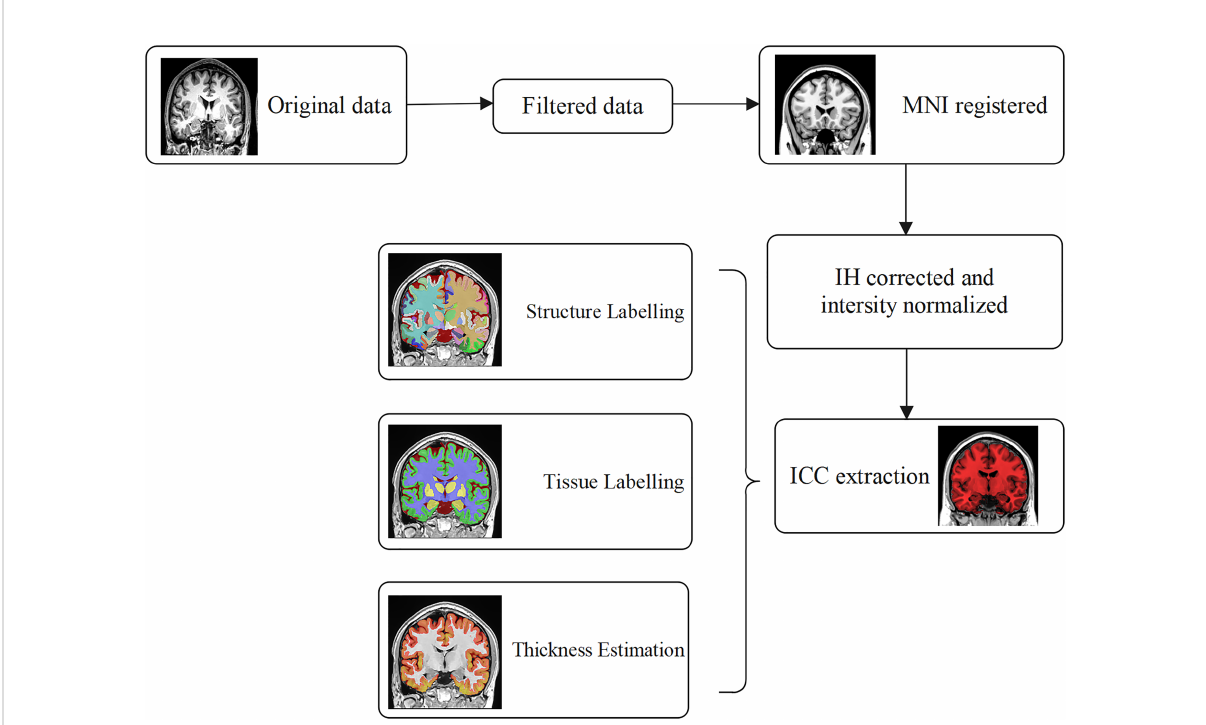
FIGURE 2 The preprocessing of 3D-T 1 WI data with online software vol2Brain. Nonlocal noise reduction fi lter, nonuniformity correction, MNI spatial registration, intensity normalization, and ICC extraction were included. The results of global tissue estimation (GM, WM, and CSF) following the segmentation results of macro structure and subcortical structure outputs